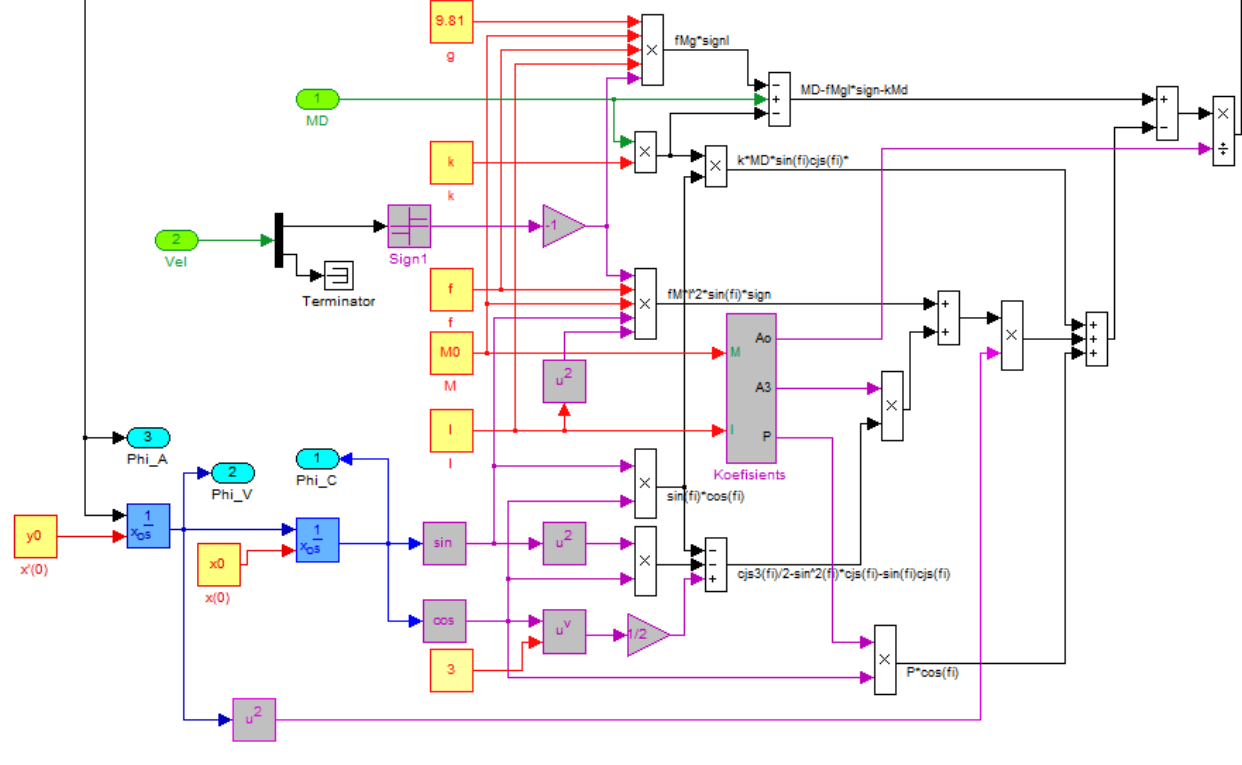
Figure 6. Simulink model of vibrating table (solution of the Eq. 36).